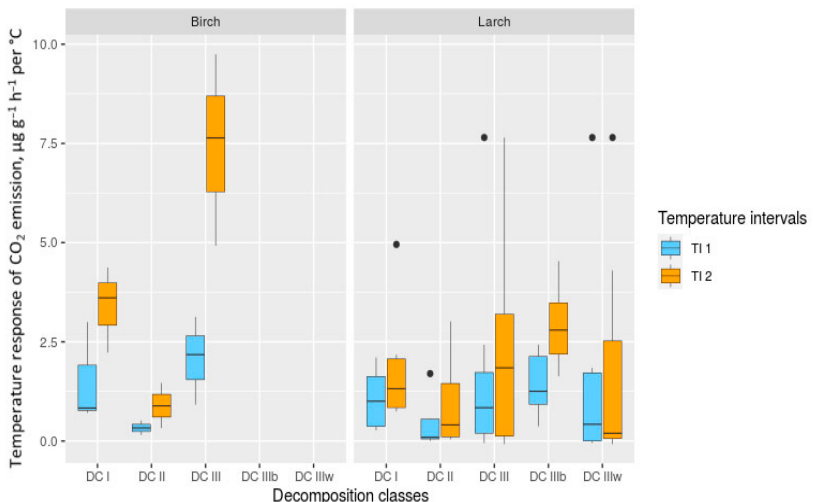
Figure 4. Box plots of temperature response of the CO 2 flux during decomposition of larch and birch CWD at different decomposition classes: TI 1—temperature interval from +5 to +15 ◦ C; TI 2—temperature interval from +15 to +25 ◦ C; DC I–DC III—decomposition classes; DC IIIb and DC IIIw—wood of Decomposition Class III decomposed by brown rot and white rot fungi, respec- tively.